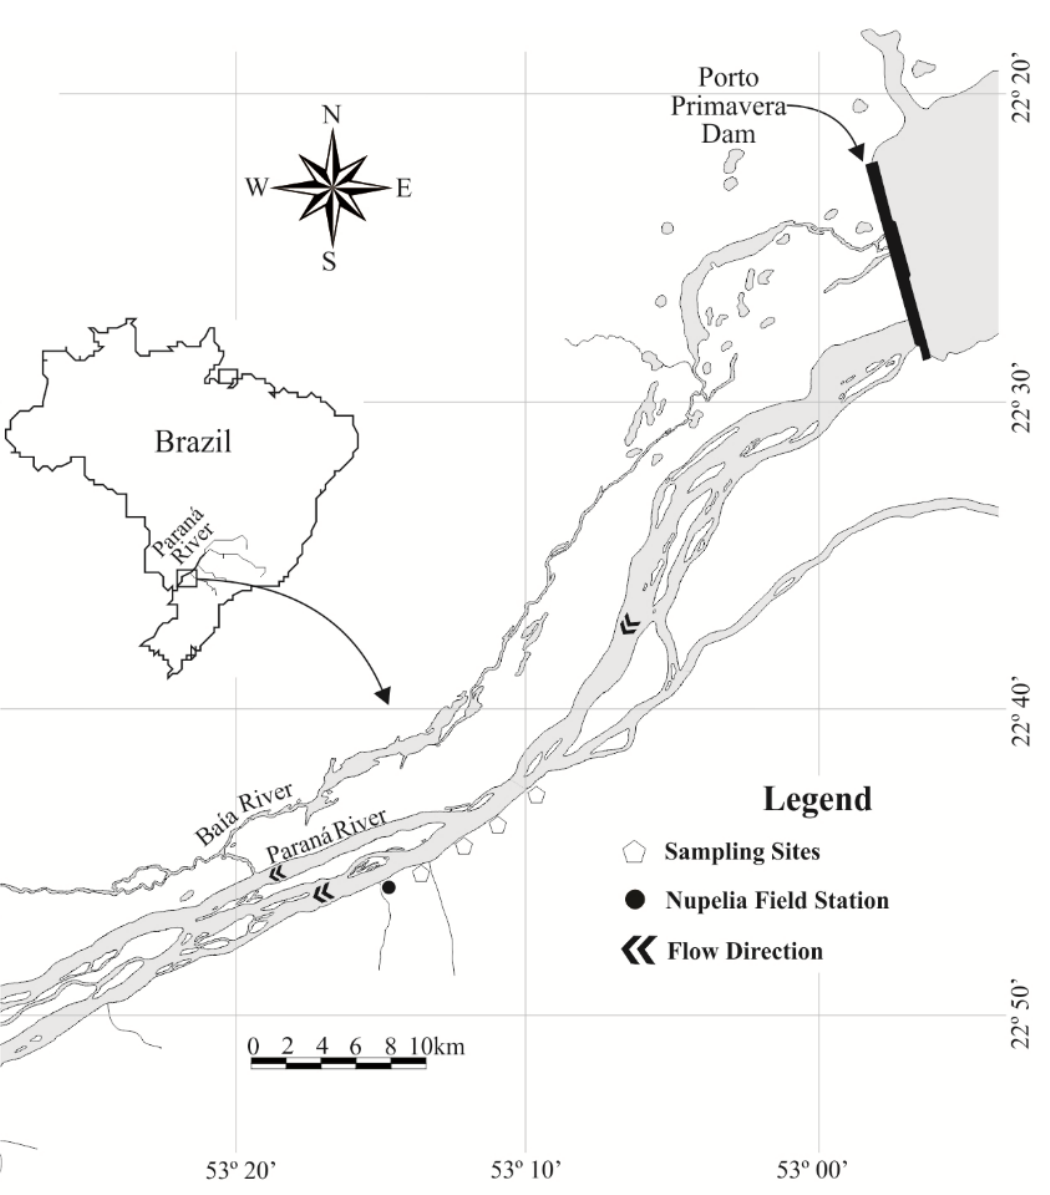
Figure 1. Map showing the sampling sites at the left bank of the Paraná